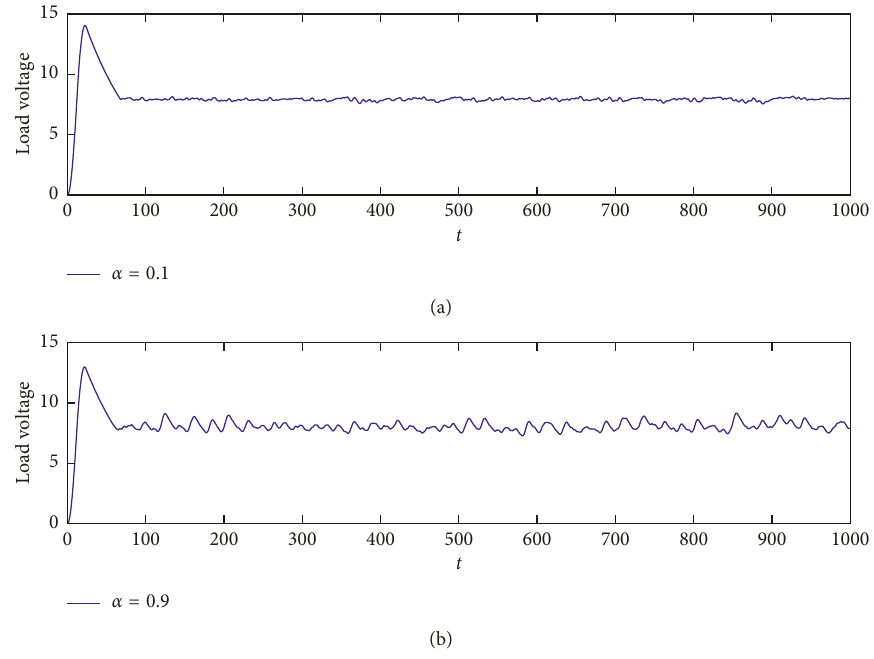
Figure 10: Comparison of control results of different feedback coefficients with same Gaussian noise.